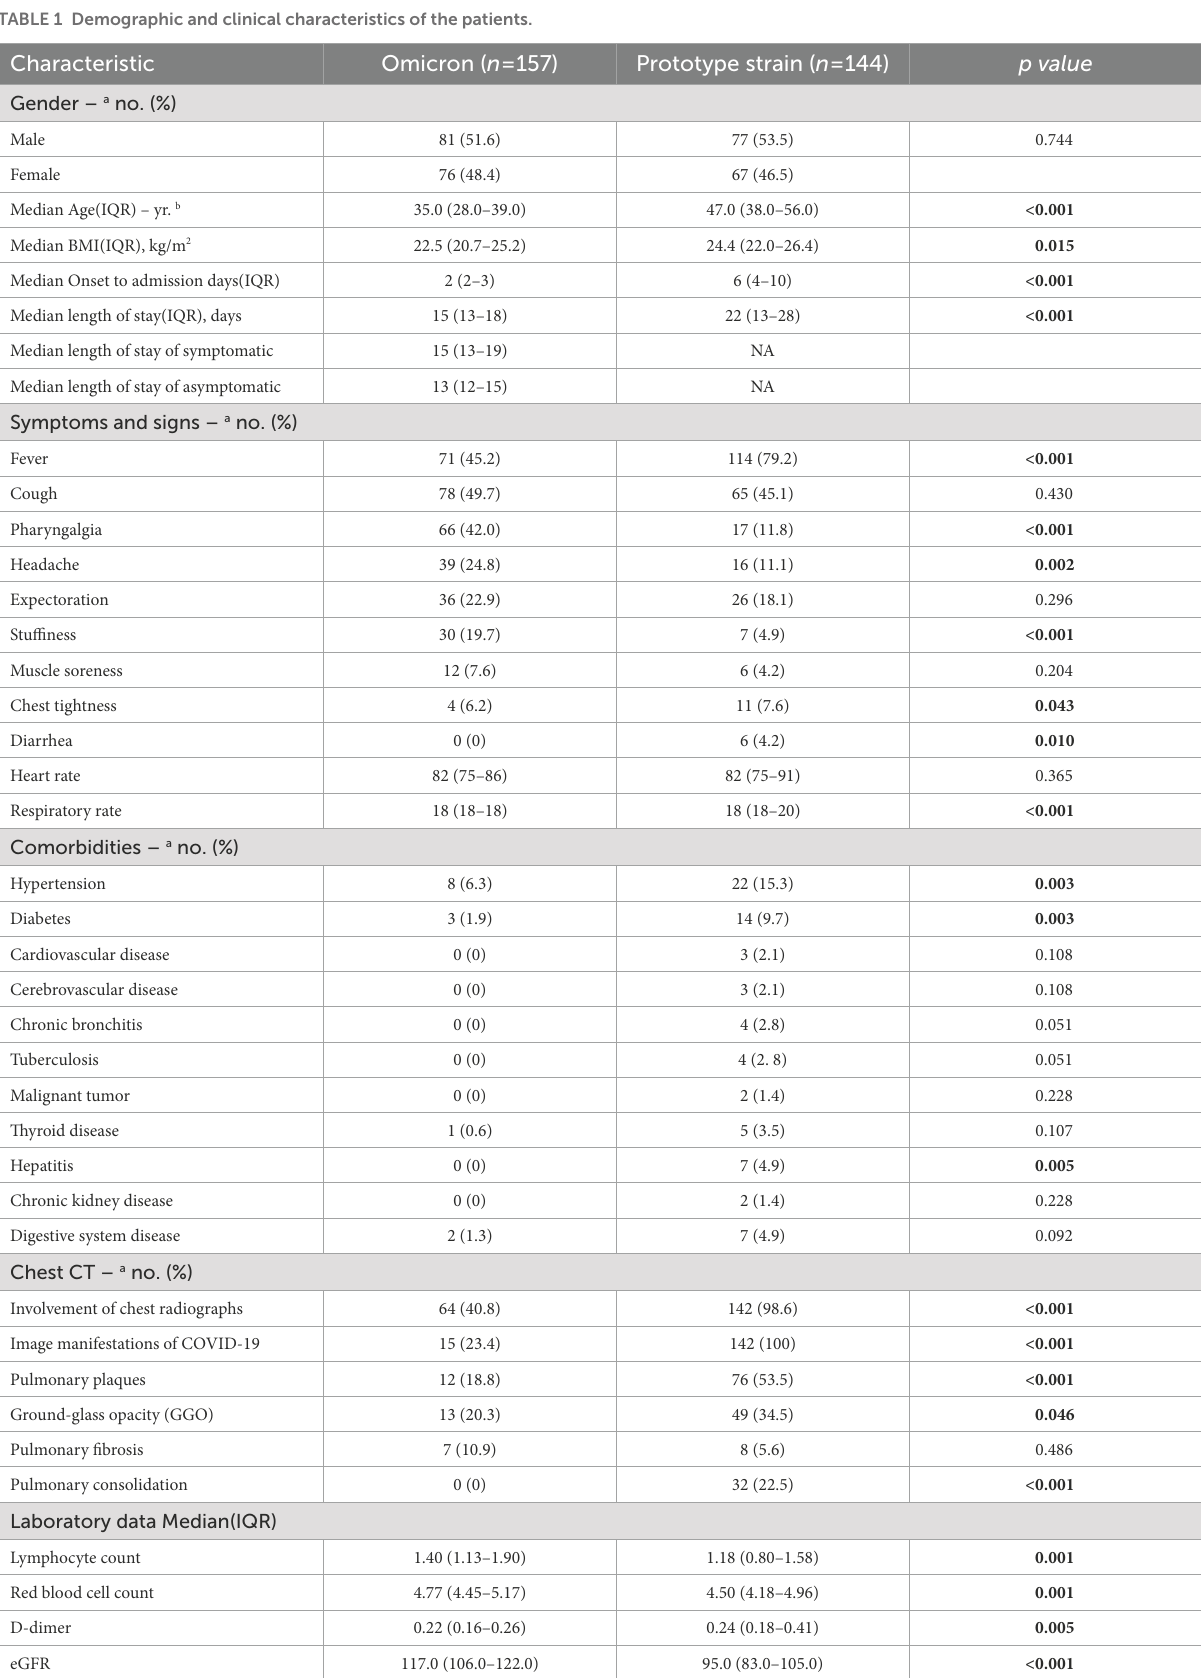
TABLE 1 Demographic and clinical characteristics of the patients. Characteristic Omicron ( n =